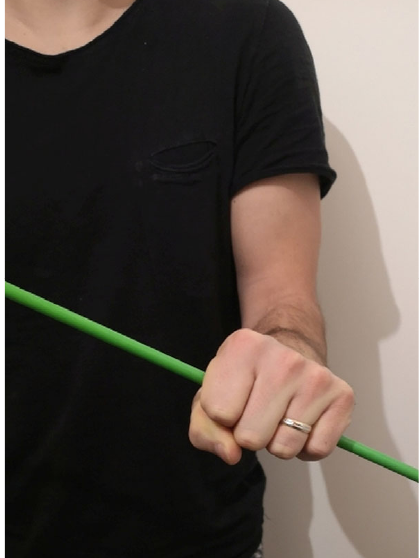
Figure 2. Forearm rotational range of motion with maximal pronation of 60°.